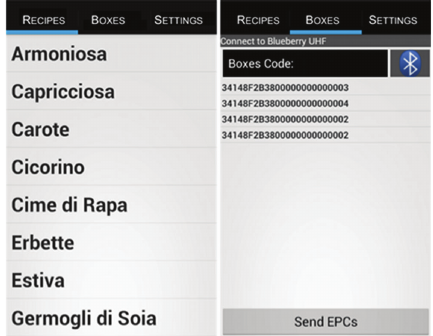
Figure 2: Snapshots of the application used by the operator in the storage